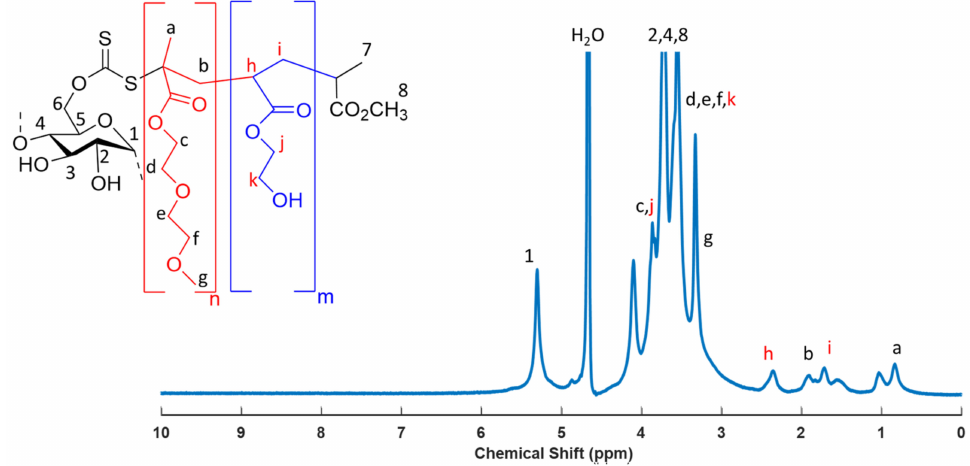
Figure 3. 1 H NMR spectrum for SNP- g -PMEO 2 MA-PHEA in D 2 O at 25 ◦ C. The labels in the spectrum identify the different types of protons in the structure on the